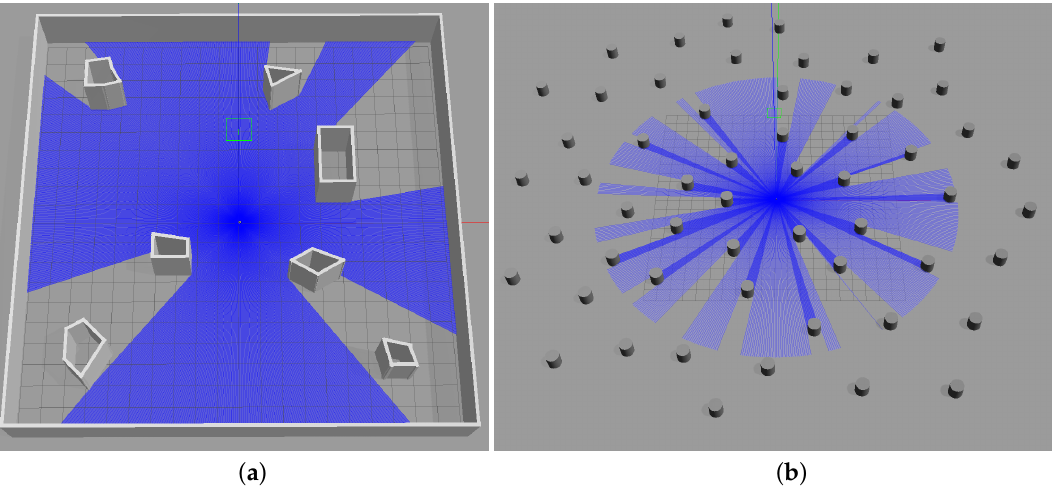
Figure 6. Environments used in Gazebo simulations. “Room” type environment is shown in ( a ), and “forest” type environment is shown in ( b